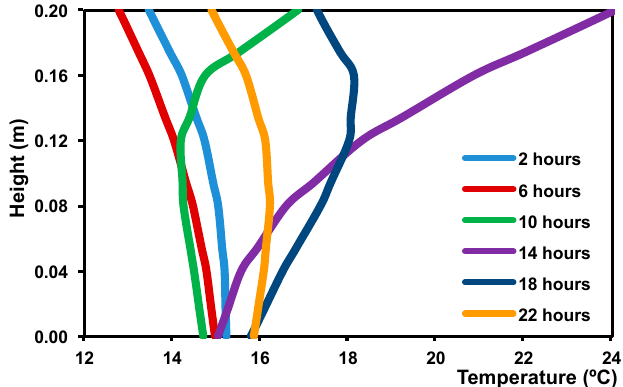
Figure 11. Sand temperature variation with the height for the 15th of March (obtained from CFD simulations).